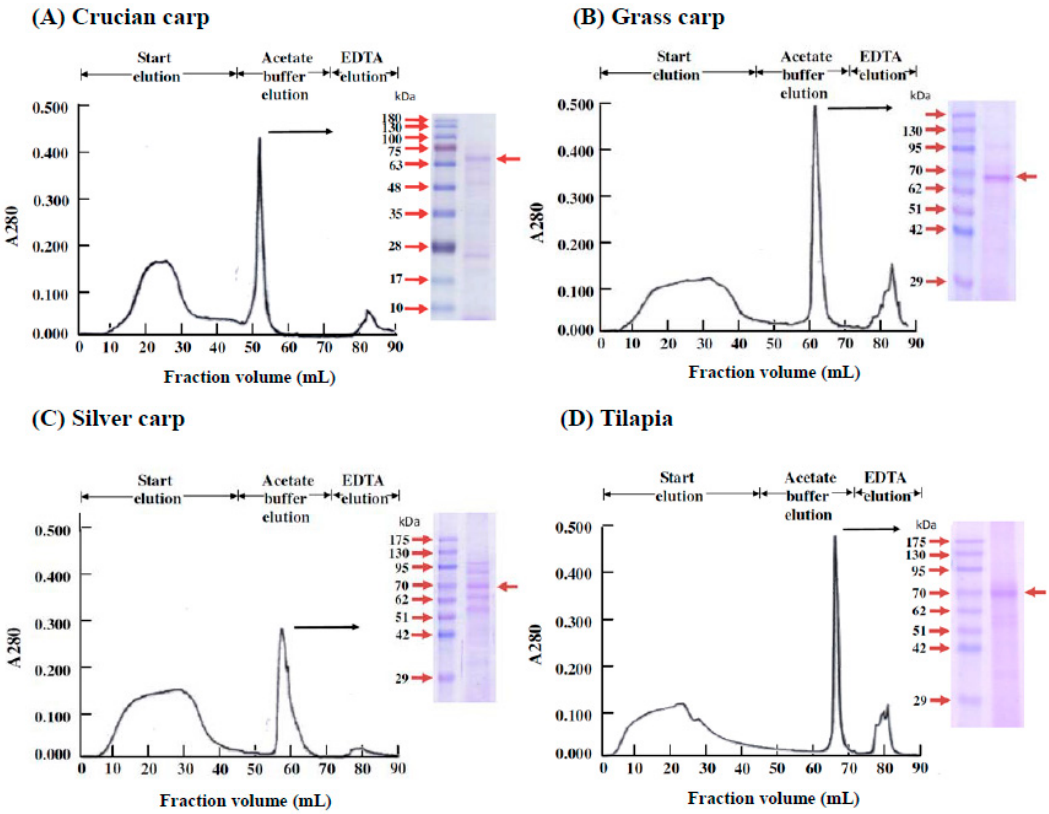
Figure 5. Isolation of the fish serum component stimulating the proliferation of new RBCs in head kidney cells of ( A ) crucian carp, ( B ) grass carp, ( C ) silver carp, and ( D ) tilapia. The head kidney cell suspension was supplemented with 10% serum from each fish species and ZnCl 2 and then cultured for three days before being harvested. The harvested cells were separated into fractions 1 and 2 using a Percoll density gradient. The cells collected from fraction 1 were extracted using a detergent buffer, and the detergent extract was purified by Zn 2+ -IMAC. The acetate buffer eluates were pooled and analyzed by SDS-PAGE under reducing conditions, followed by staining with Coomassie blue to visualize the protein bands. The arrowhead denotes the position of the protein identified by nano-LC-MS/MS analysis as transferrin in crucian carp, grass carp, silver carp, and tilapia, respectively.